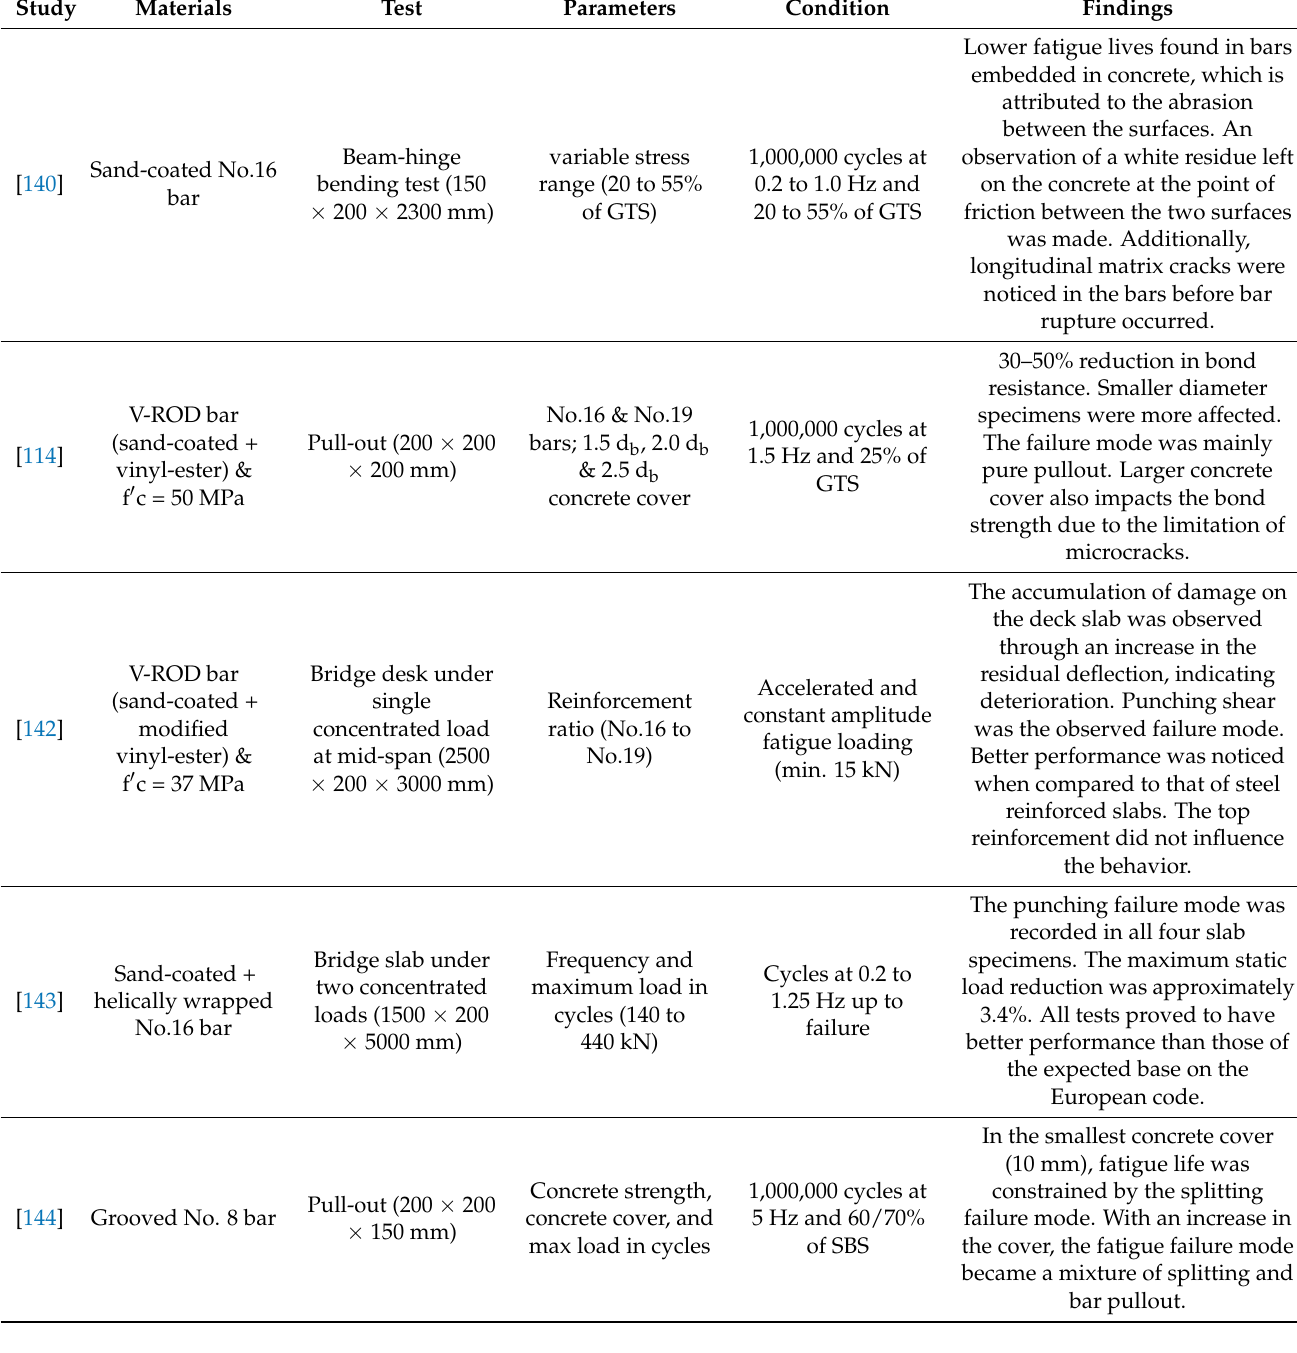
Table 3. Recent studies on fatigue in GFRP-RC